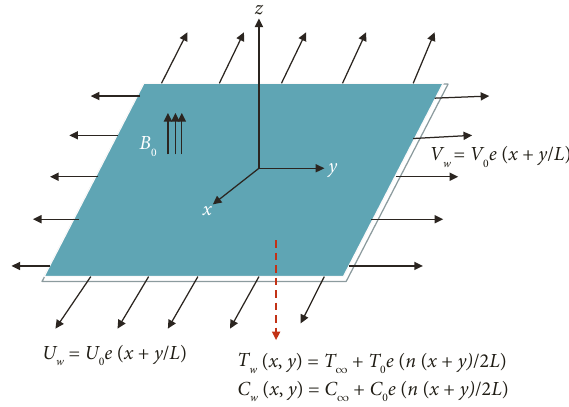
Figure 1: Geometry of the flow